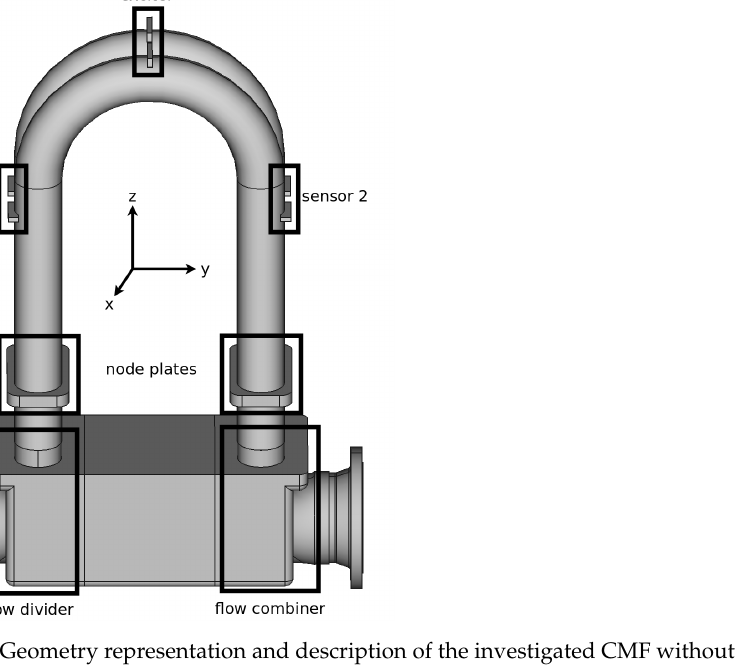
Figure 4. Geometry representation and description of the investigated CMF without outer